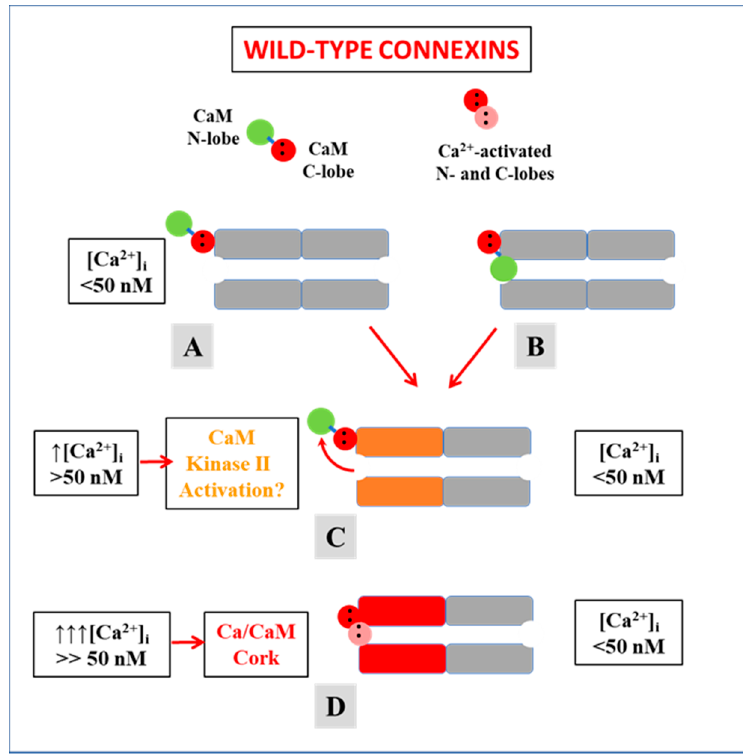
Figure 13. Schematic representation of Ca-CaM-Cork gating. Our hypothesis is that under normal conditions, while most channels are open ( A ) some are closed ( B ) by the CaM-Cork mechanism ( B ). With a small [Ca 2+ ] i rise above resting values, CaMKII becomes activated, possibly resulting in the opening of CaM-Cork gated channels ( C ; orange connexins). With greater [Ca 2+ ] i rise the Ca 2+ -activated CaM’s N-lobe interacts hydrophobically and electrostatically with the connexin’s gating site and plugs the channel’s pore ( D ; red connexins), probably also causing conformational changes in connexins ( D ).